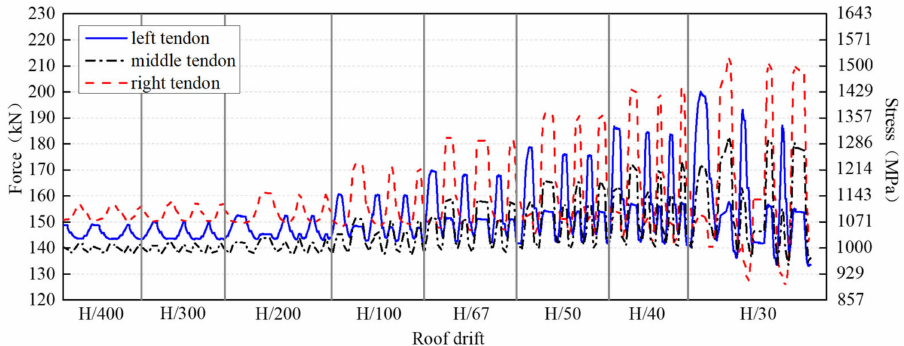
Figure 12. Internal force-time histories of post-tensioning